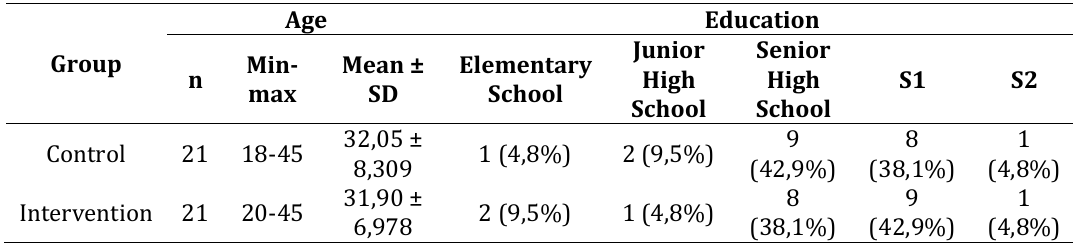
Characteristics of respondents